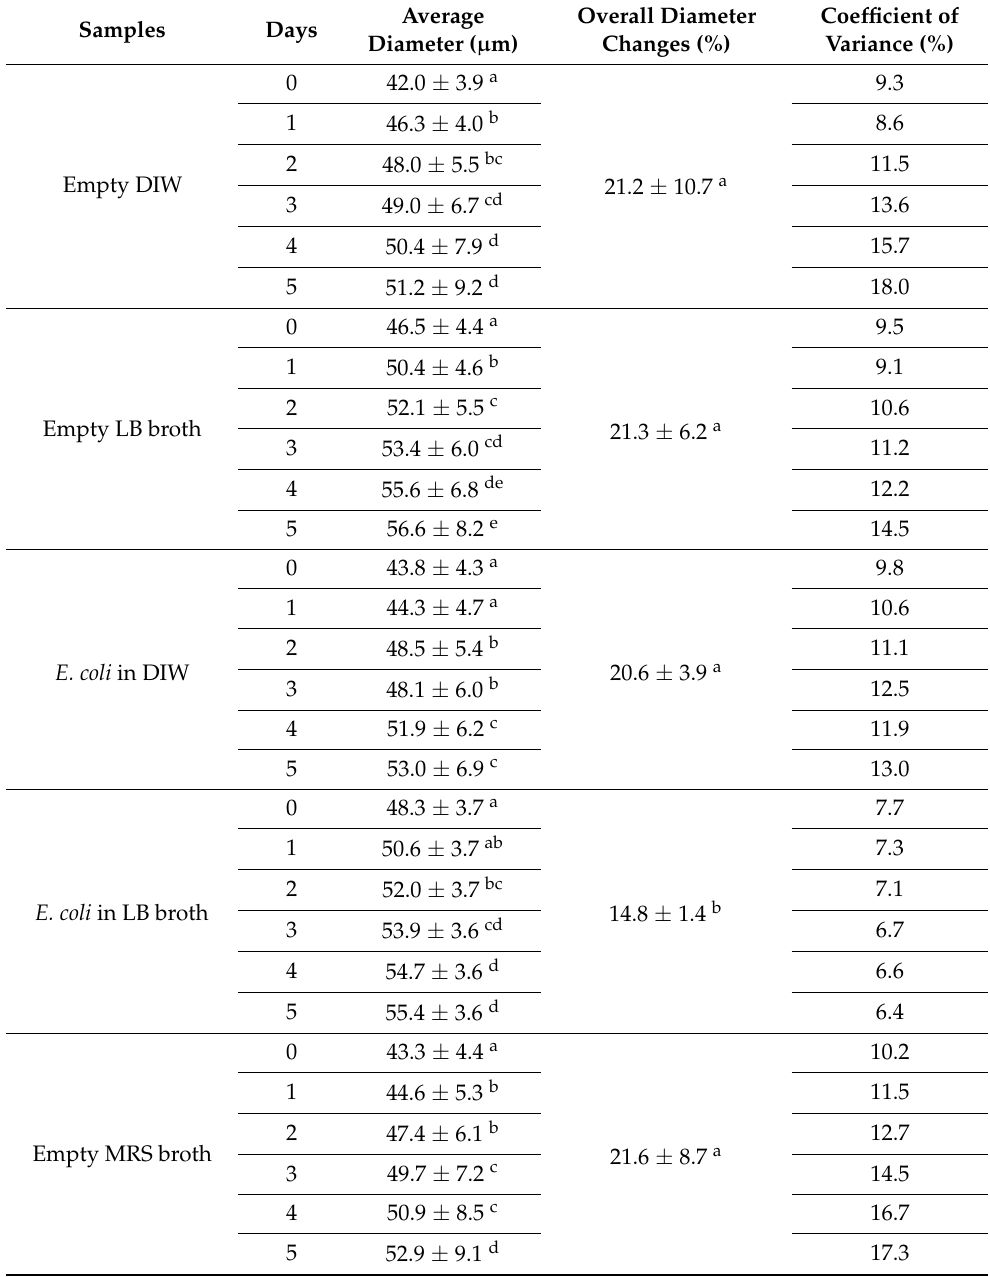
Table 1. Summary of changes in droplet stability during five days of storage at 25 ◦ C. Data represent the mean ± standard deviation from 3 independent experiments with N = 900 droplet. The average diameters were measured daily during five days of storage and the overall change in diameter (%) was measured based on the diameter at day 0 with respect to day 5. The CV values were measured by dividing the standard deviation by the average droplet diameter for each storage day. The average diameters at different storage days were compared within each sample while the overall diameter changes were compared between samples. Mean diameters with different letters indicate significant different ( p < 0.05) between samples. Samples Days